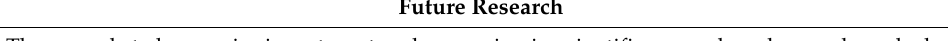
Table 1. Research and policy implications.